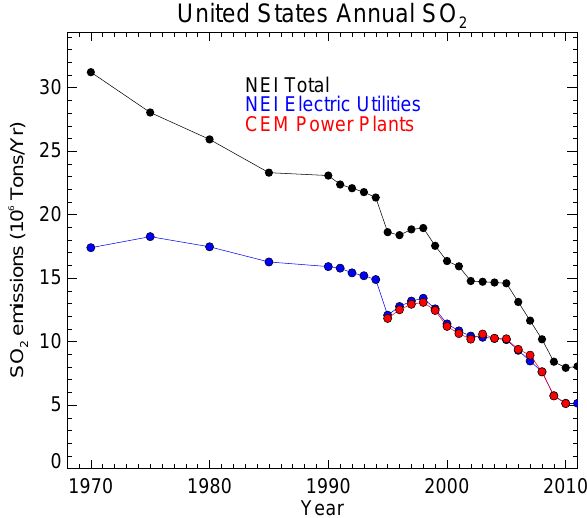
Fig. 11. US annual SO 2 emissions (million t yr − 1 ) from the Na- tional Emission Inventory (NEI) total sources, NEI electric utility sources, and continuous emission monitoring (CEM) power plant